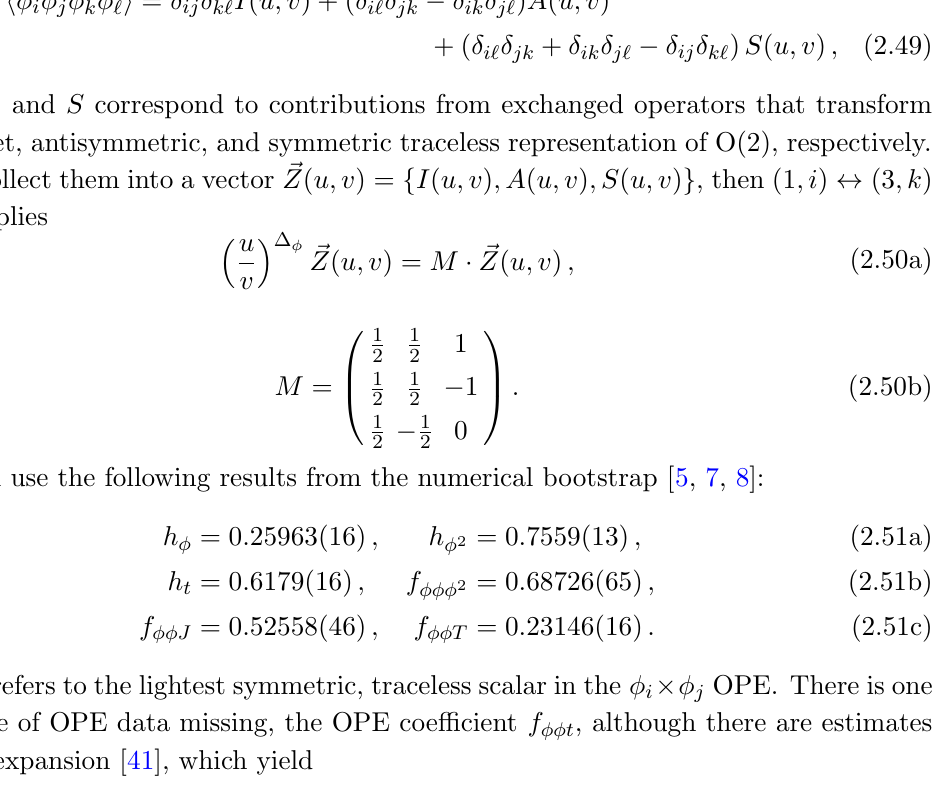
Table 1 . We list results for the twists and OPE coe(cid:14)cients for the double-twist family [ (cid:27)(cid:27) ] in the 3d Ising model by either matching at z = : 1 or using the na(cid:127)(cid:16)ve log z matching valid for perturbative anomalous dimensions. Approximate errors come from numerical